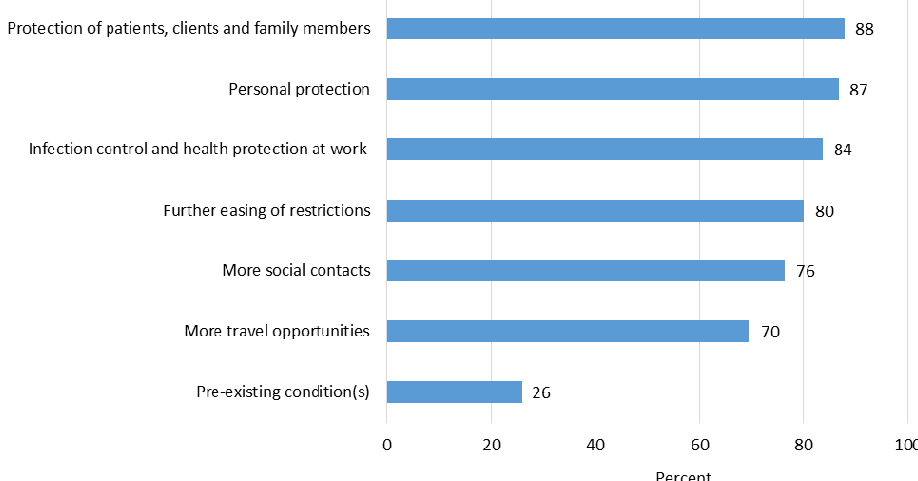
Figure 1. ReasonsforCOVID-19vaccination(stronglyagree/agree; Figure 1. Reasons for COVID-19 vaccination (strongly agree/agree; percentage relative to the total sample).